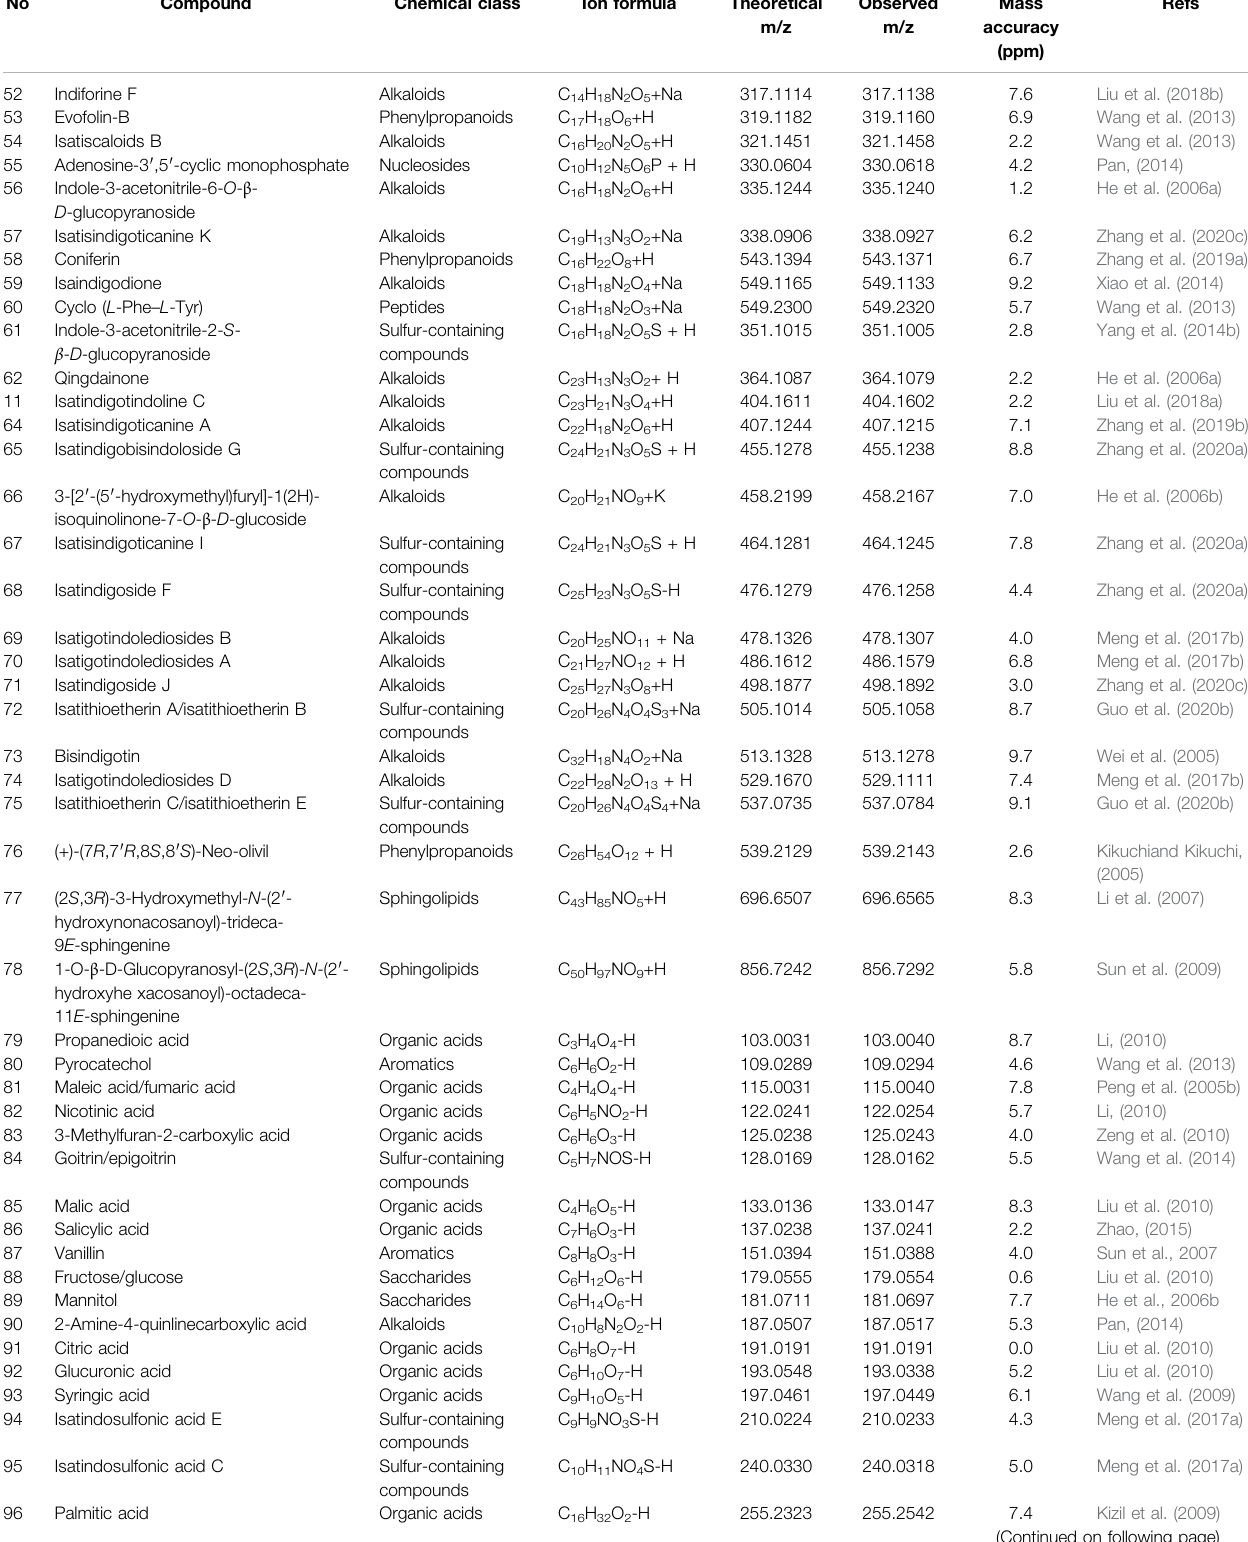
TABLE 2 | ( Continued ) Assignment of ions observed in the matrix-assisted laser desorption and ion trap – time-of- fl ight (MALDI-IT-TOF) mass spectrometry imaging (MSI) of the dried root of Isatis indigotica with references regarding shown